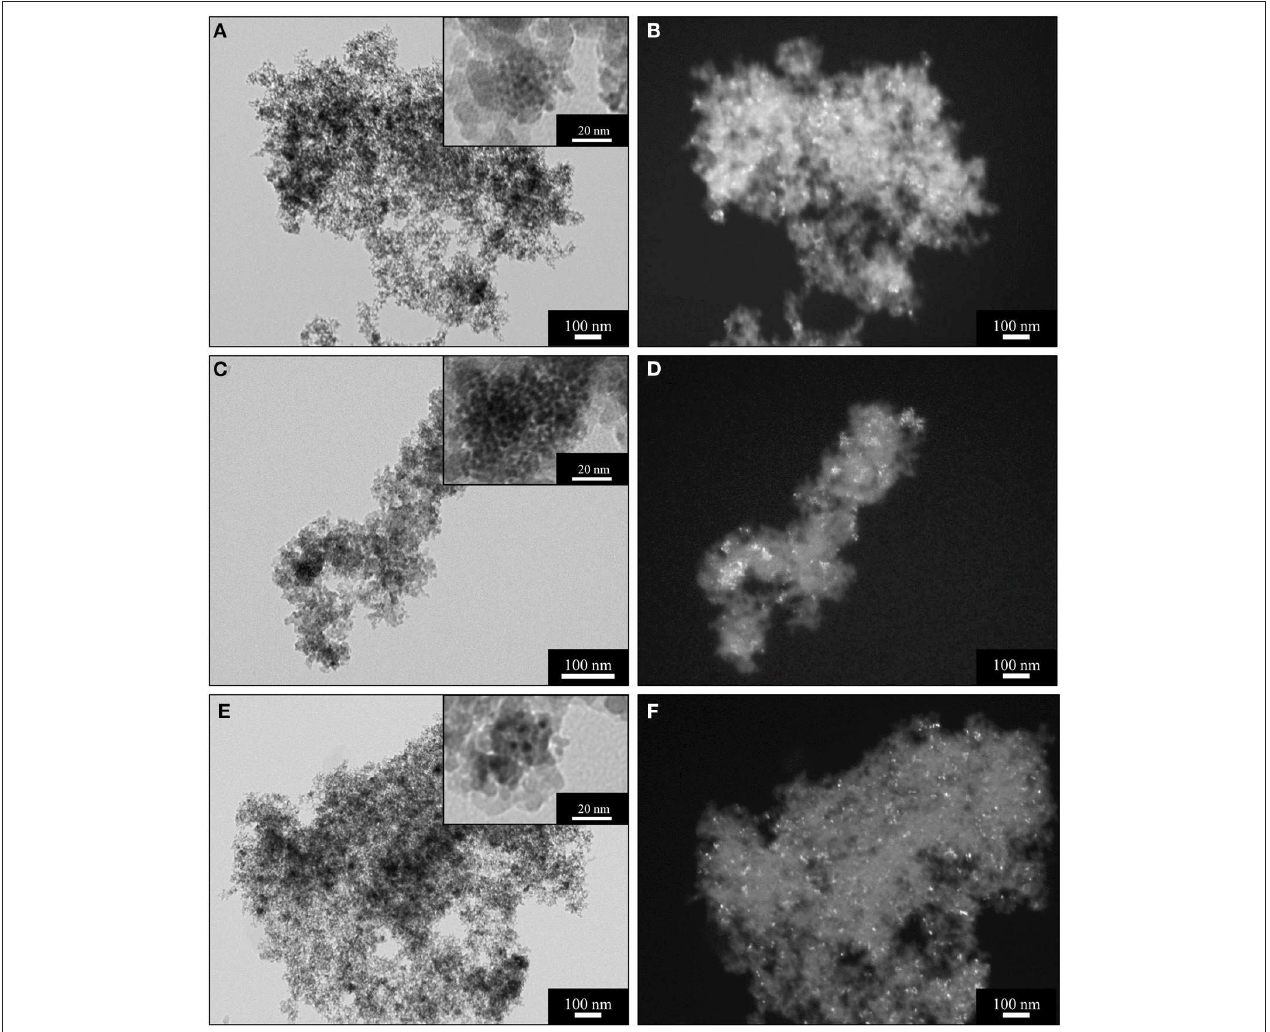
FIGURE 2 | BF (left) and DF (right) TEM images of the sample A_15_CeO 2 after supercritical drying (A,B) ; after thermal treatment at 450 ◦ C (C,D) ; after thermal treatment at 900 ◦ C (E,F) .